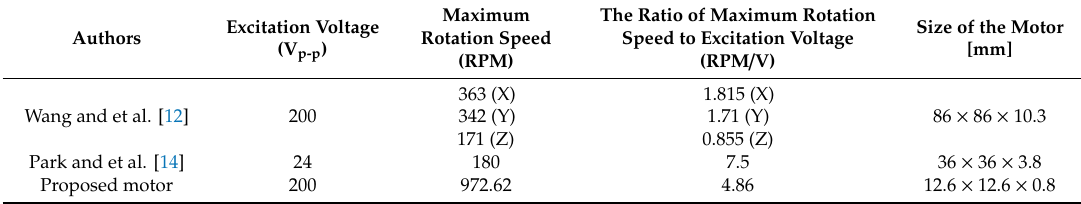
Table 4. Comparison of di ff erent small size rotary